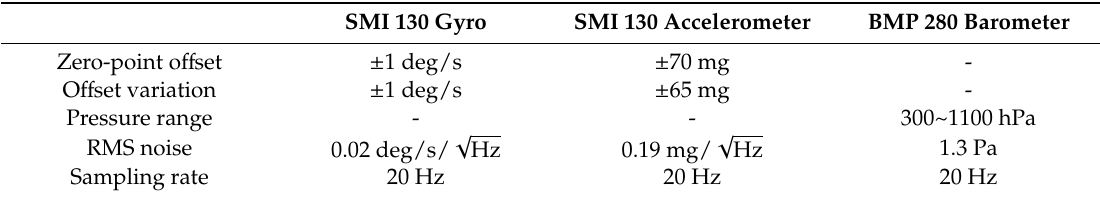
Table 2. Specification of the